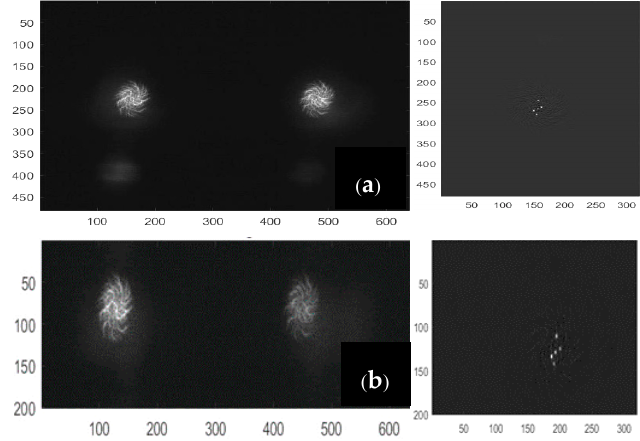
Figure 14. Image Frames and Reconstructed Frames ( a ) before Reducing the Region of Interest (ROI); ( b ) after Reducing the ROI. Table 6. Execution time for full and reduced ROI.